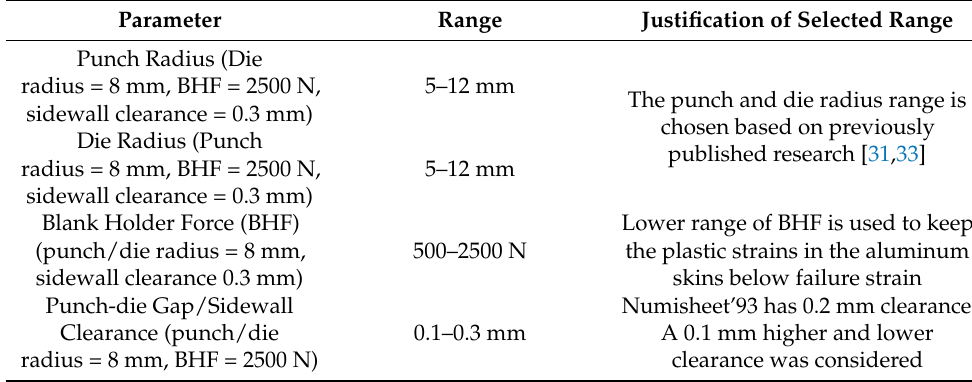
List of tool design and process parameters studied for springback of Al/PP/Al sandwich laminates.